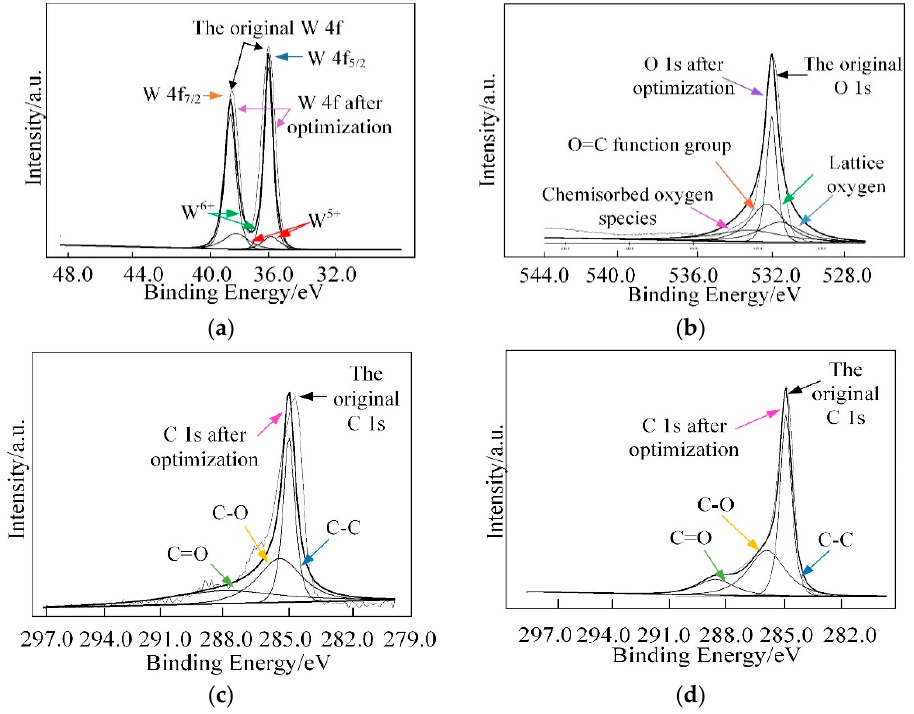
Figure 7. ( a ) High-resolution XPS spectra in the vicinity of the W 4f peaks; ( b ) O 1s peak; ( c ) C 1s peak of WG1; and, ( d ) C 1s peaks of rGO.